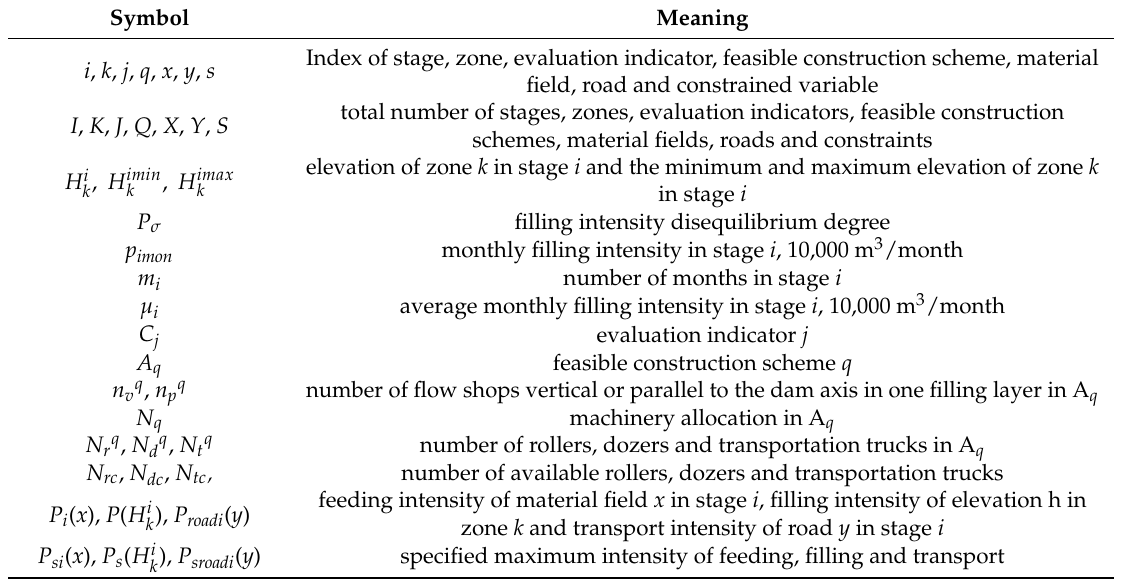
Figure 3. Sketch of construction stage and zone optimization. Table 1. The meaning of symbols proposed in this